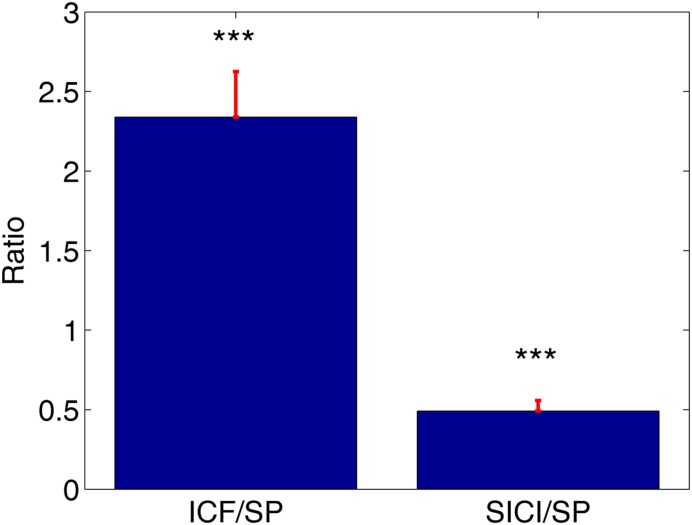
The average value of the normalized motor evoked potentials (MEPs) with corresponding standard errors. Intracortical facilitation (ICF)/single-pulse (SP) = 2.34, short-interval intracortical inhibition (SICI)/single-pulse (SP) = 0.49, ∗∗∗P < 0.001.